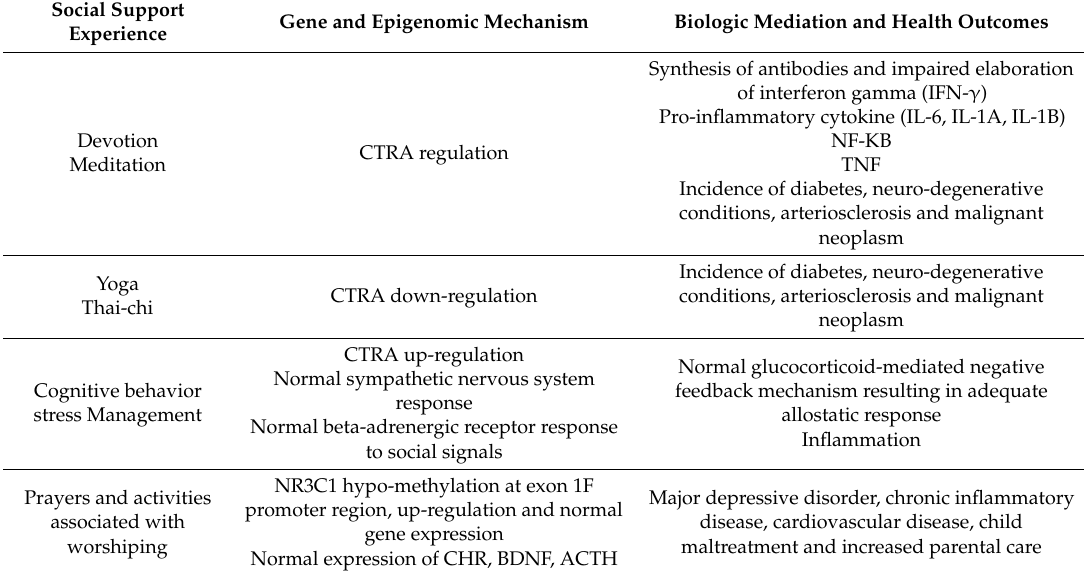
Table 2. Candidate genes implicated in social interaction and implied spiritual network support system